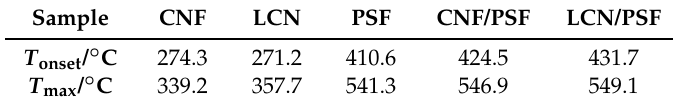
Table 2. T onset and T max analysis of CNF, LCN, PSF, CNF/PSF and LCN/PSF.